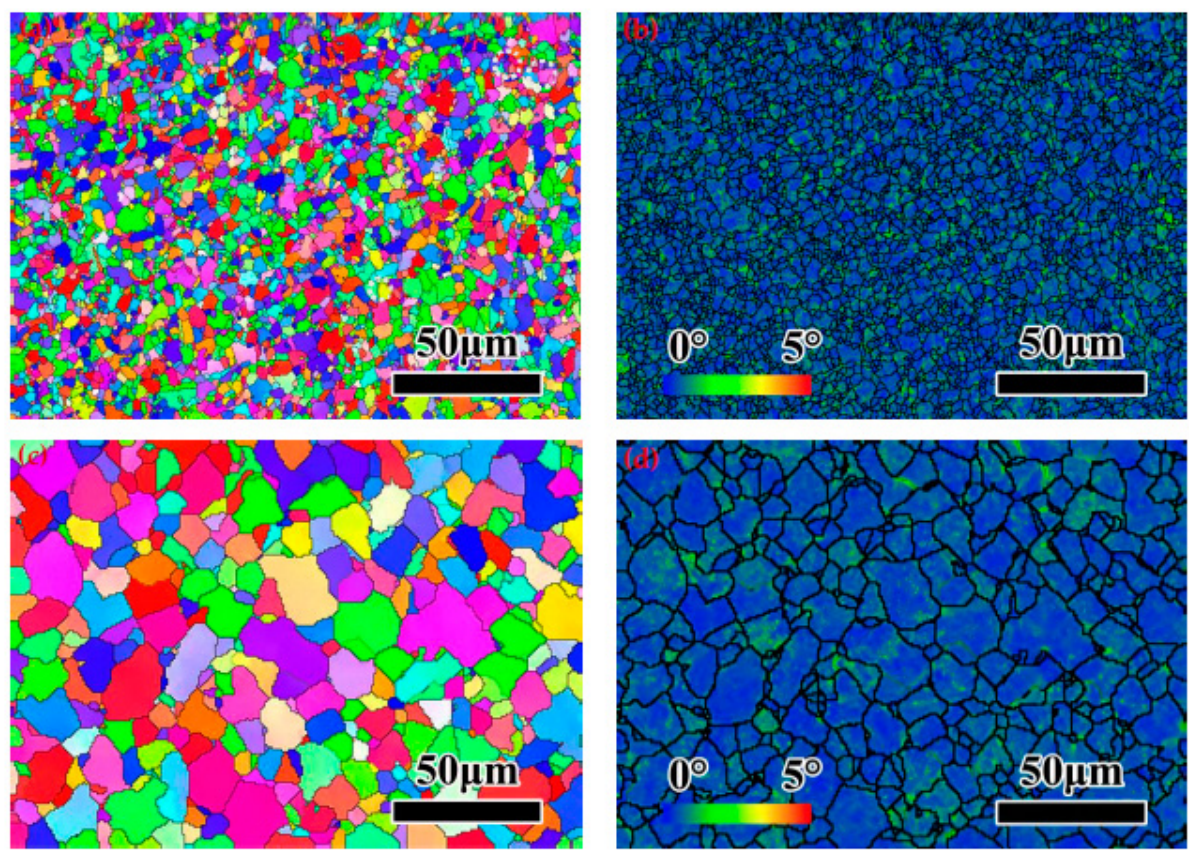
Figure 6. ( a ) IPF map of the TMAZ, ( b ) KAM map of the TMAZ, ( c ) IPF map of the WZ, ( d ) KAM map of the WZ.